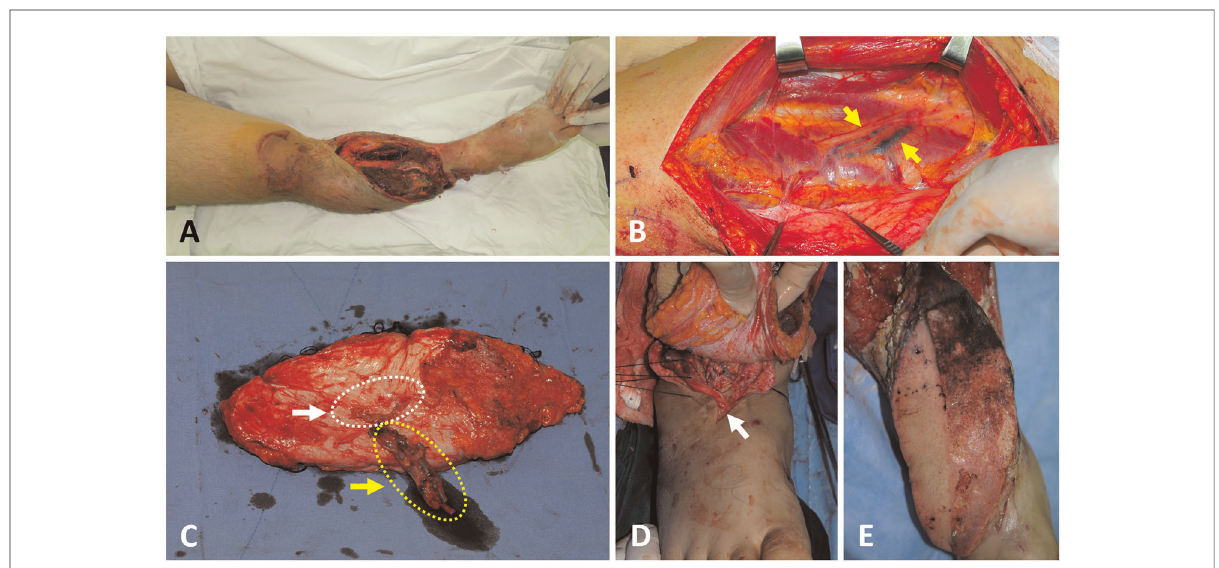
FIGURE 3 A case showing DVT in two concomitant veins of the DB-LCFA found during the harvest of the anterolateral thigh perforator fl ap. ( A ) A 25-year-old male sustained severe tibia open fractures accompanied by a soft tissue defect on the right lower leg. ( B ) Surgical exposure of the DB-LCFA reveals dark-colored veins (yellow arrow). ( C ) DVT was identi fi ed in the middle of both concomitant veins of DB-LCFA under close inspection of the pedicle. The whole segment of DB-LCFA and its concomitant veins (yellow arrow and dotted line) were resected from the pedicle because DVT could not be removed. Then, only the perforator portion of the pedicle (white arrow and dotted line) was used for anastomosis. ( D ) A vascular anastomosis was performed between the perforator vessels of the fl ap and dorsalis pedis artery and one of its vena comitantes. Additionally, one perforator vein of the fl ap was anastomosed to a super fi cial vein around the recipient site. ( D ) The fl ap survived with partial necrosis of the proximal portion. DVT, deep vein thrombosis; DB-LCFA descending branch of the lateral circum fl ex femoral